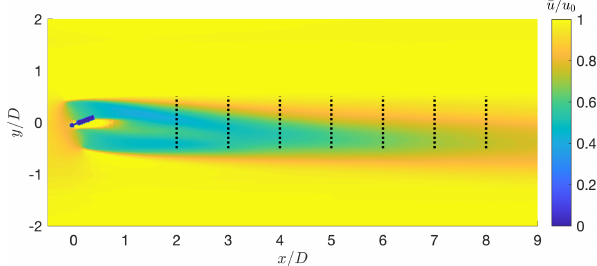
Figure 15. Wake of the G1 turbine for the yaw misaligned case. The black dashed lines indicate the locations of virtual downstream